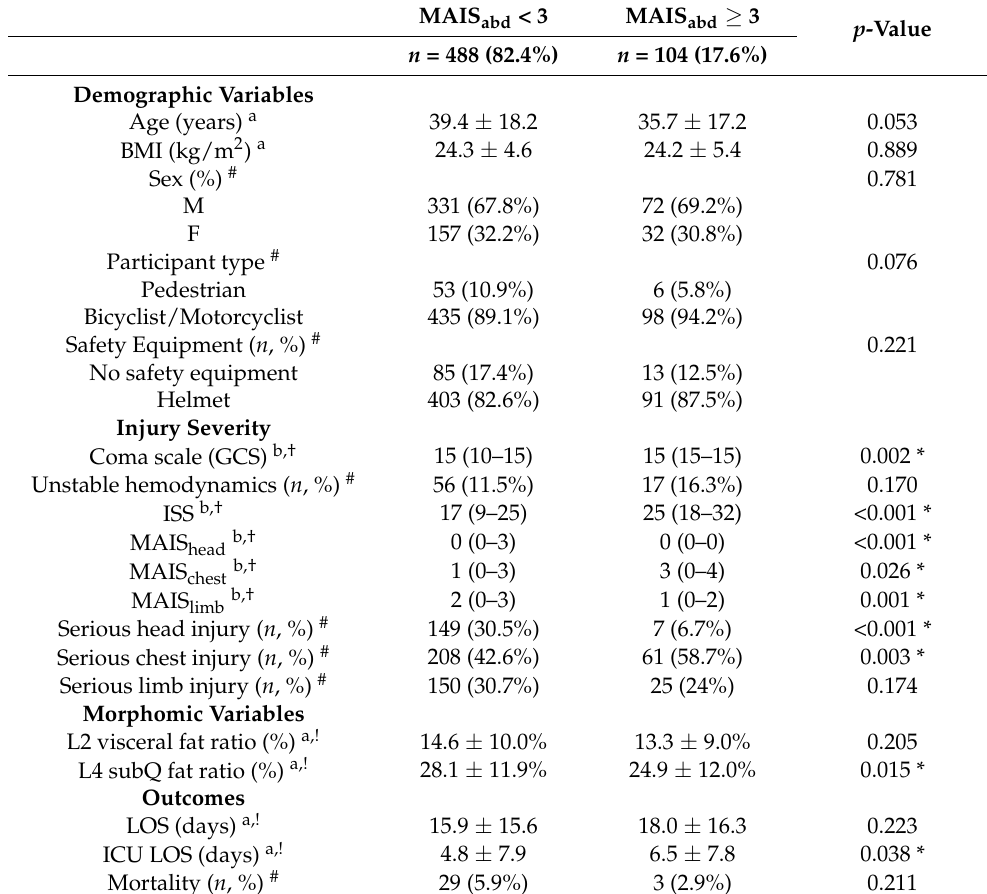
Table 2. Univariate analysis of risk factors for serious abdominal injury (MAIS abd ≥ 3) in vulnerable road users.